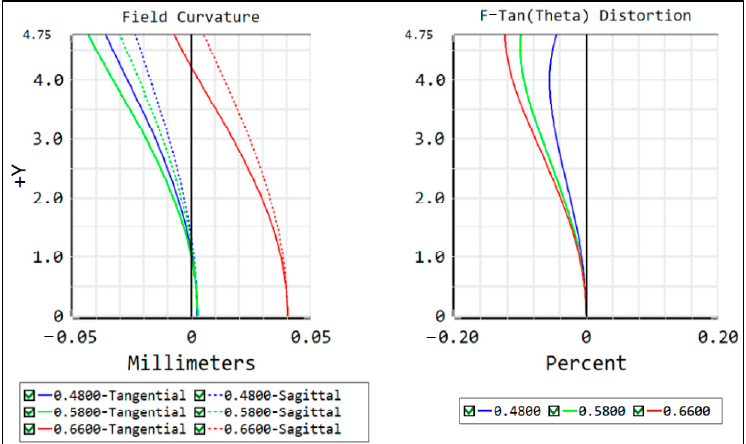
Figure 12. Field curvature and distortion curves of the concentric multi-scale optical system.